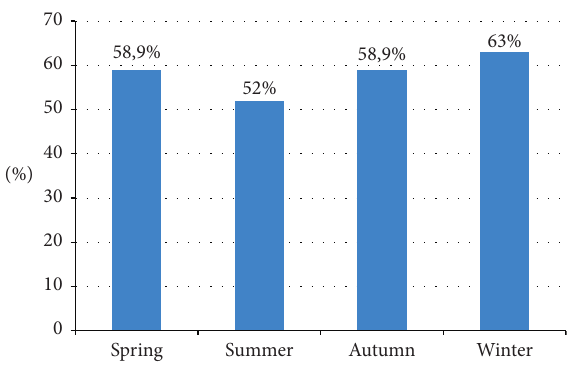
Figure 1: Patch test positive reactions within